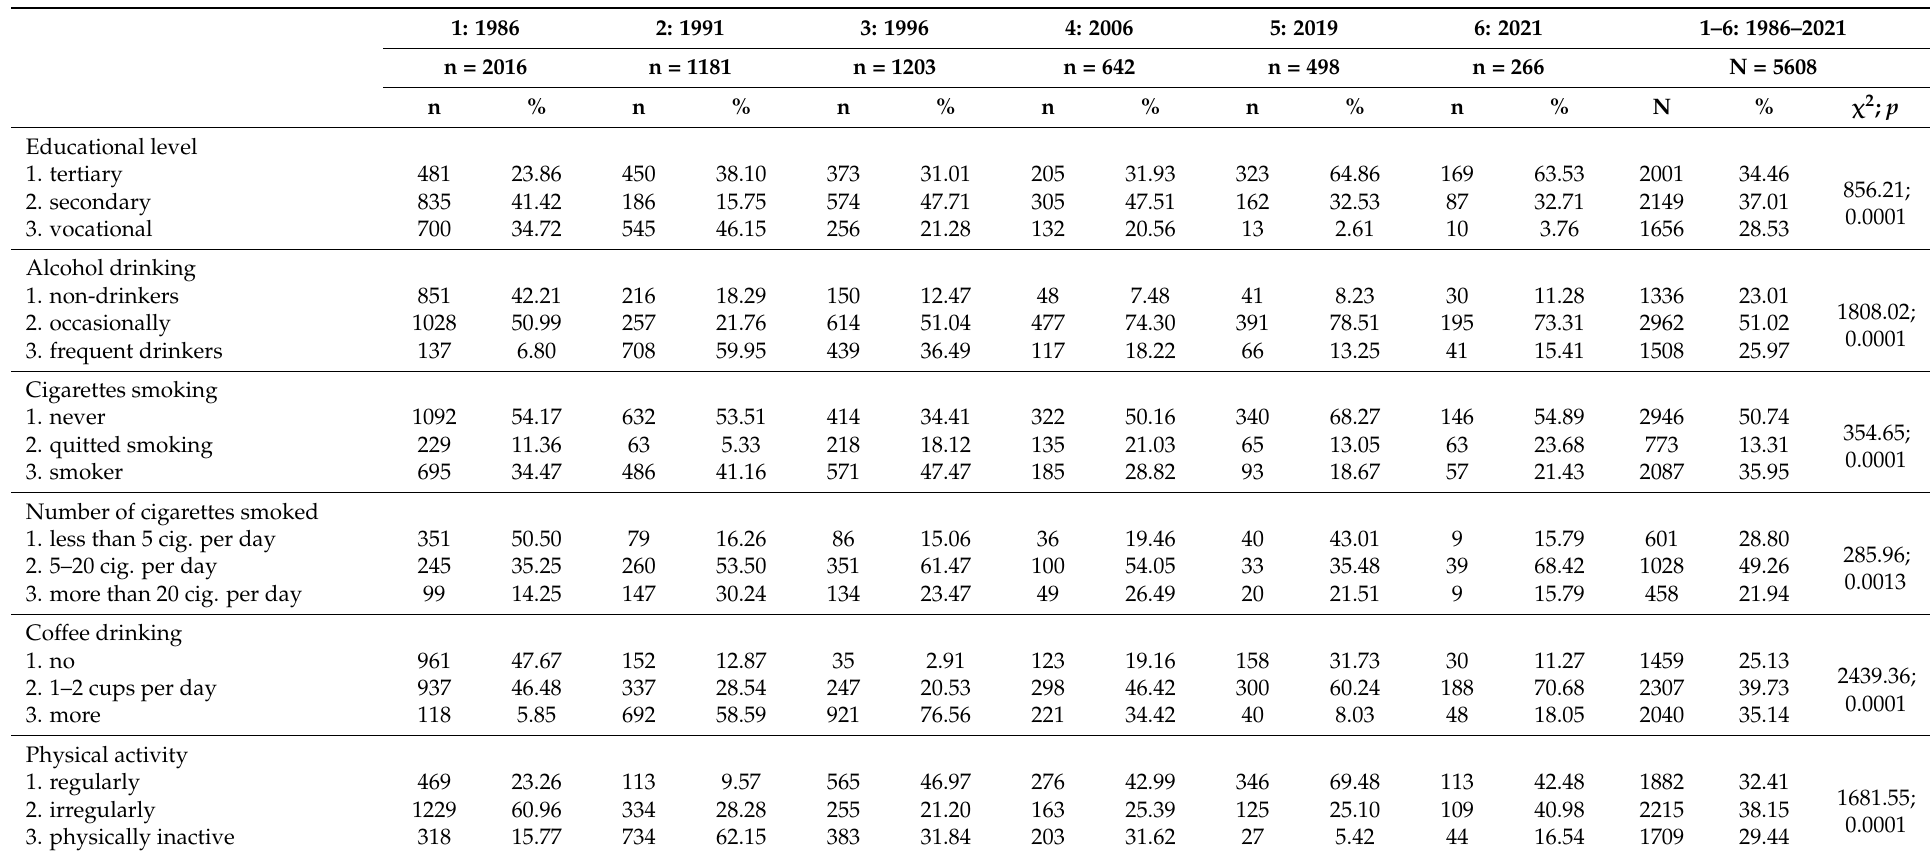
Table 1. Characteristics of educational level and women’s life style in particular years (N, percentages—%) and the importance of the differences over time (Chi-square test; p —the level of